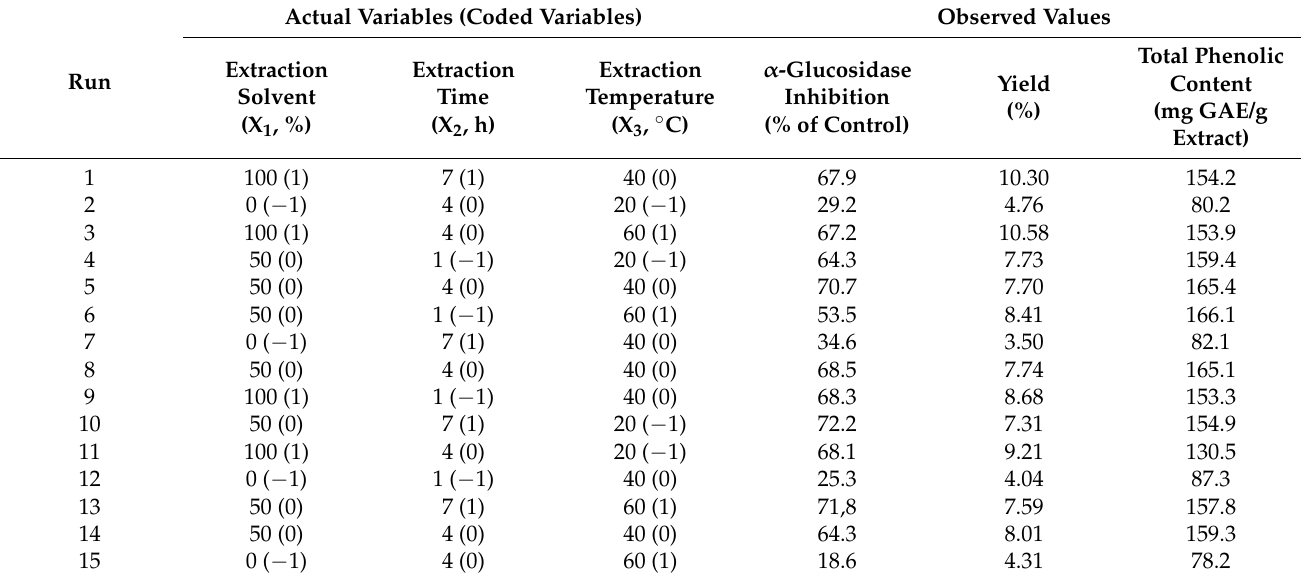
Table 3. A Box–Behnken Design for independent variables and their